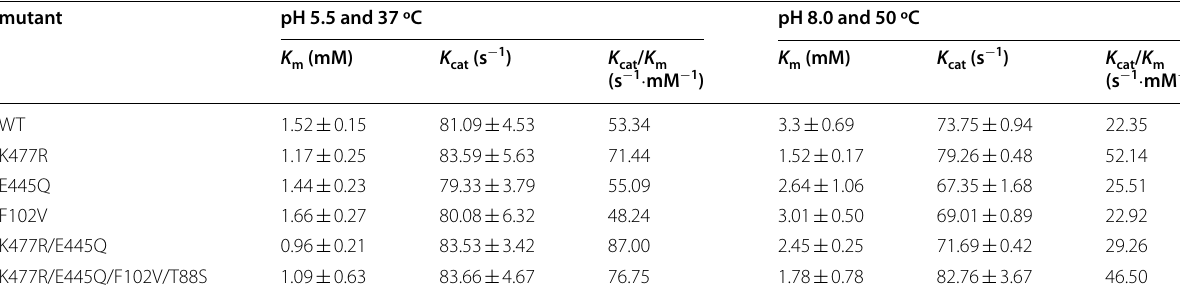
Table 2 Kinetic parameters of the wild-type CadA and its mutants mutant